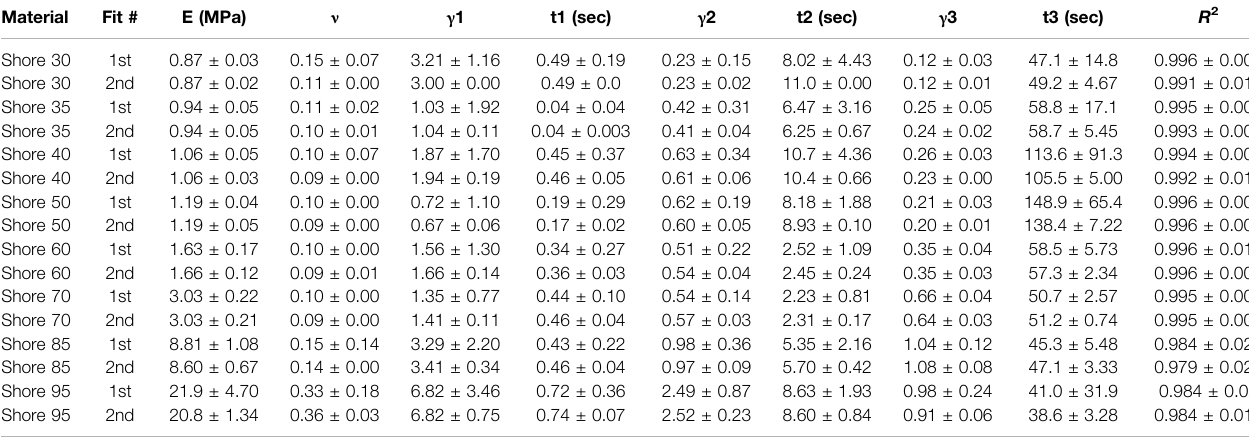
TABLE 1 | Nonlinear viscoelastic compressible Neo-Hookean fi t to J750 Shore materials. Table of compressible nonlinear viscoelastic compressible Neo-Hookean parametersfortheJ750Shorematerialsalongwiththe R 2 valuesofthe fi tbetweentheconstitutivemodelandexperimentaldata(n=6specimenspermaterialexceptfor Shore 30 with n = 5 specimens per material). Coef fi cient Set refers to the initial guess ( fi rst) with wide bounds on the parameters followed by a second optimization run with the bounds being the mean parameters from the fi rst optimization run ±10% of the mean.